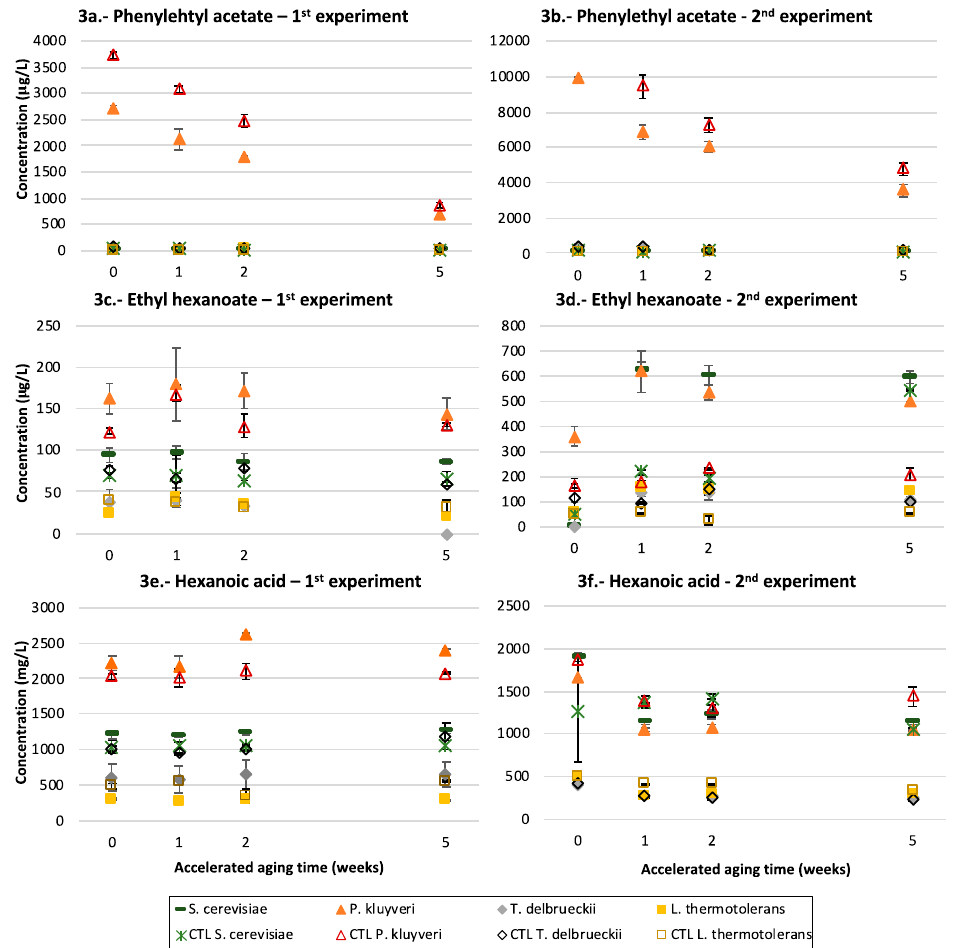
Figure 3. Acetate esters, fatty acids and their ethyl esters: evolution of ( a , b ) phenyl acetate, ( c , d ) ethyl hexanoate and ( e , f ) hexanoic acid in the Riesling and Garnacha experiments after 1, 2 and 5 weeks of accelerated aging and according to the yeast strain that carried out the fermentation: S. cerevisiae or P. kluyveri, T. delbrueckii and L. thermotolerans sequentially inoculated with S. cerevisiae . The samples without precursors are indicated as CTL.